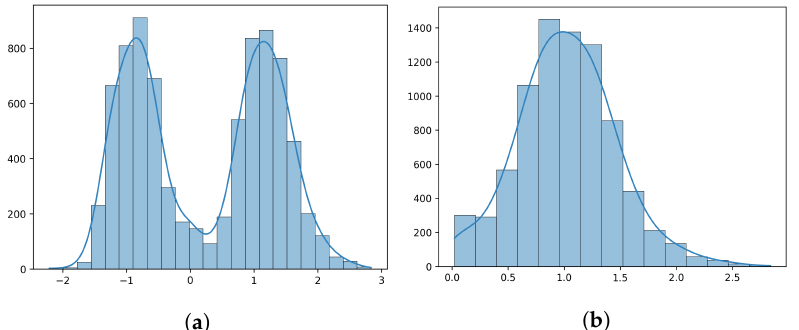
Figure 8. Histogram of non-zero sparse coefficients for atom 1 of the learned dictionary. ( a ) coefficients with non-zero values, ( b ) coefficients with absolute non-zero